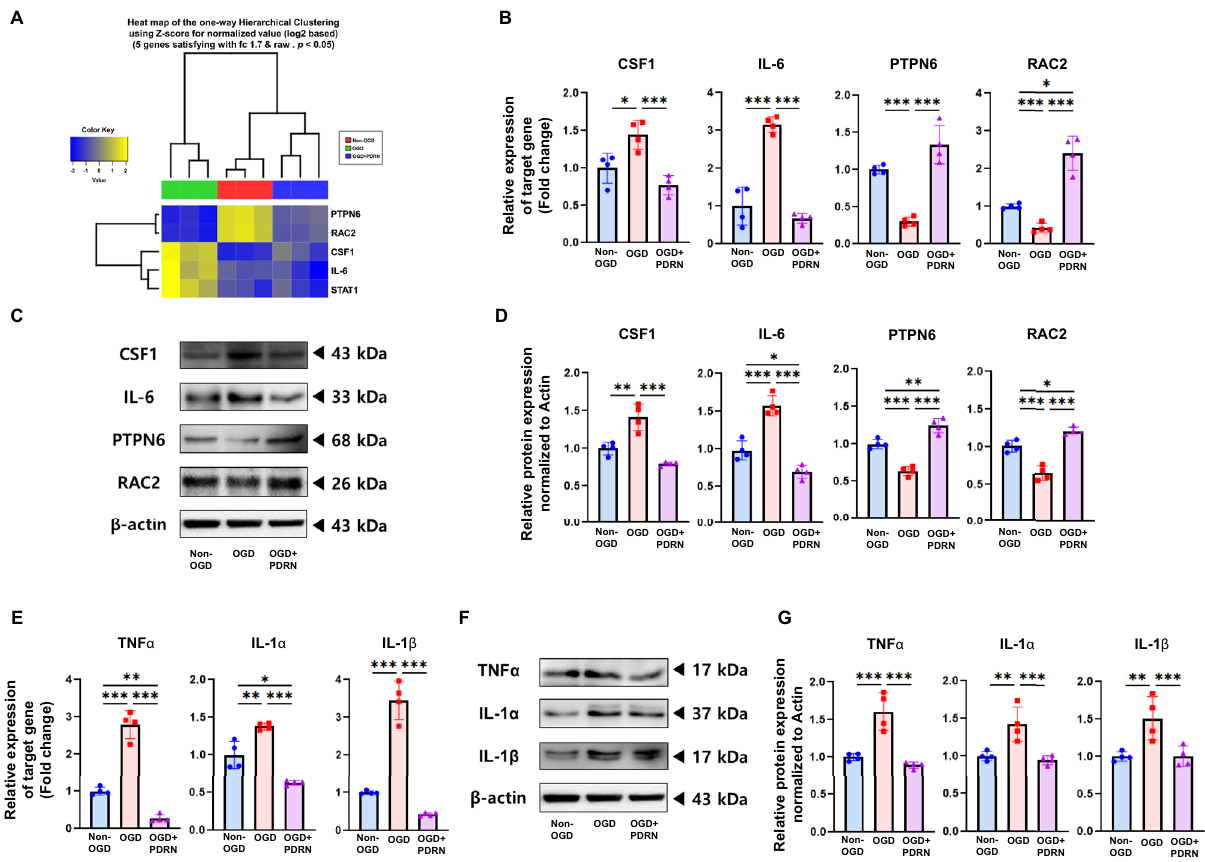
Figure 2. Effect of PDRN on genes related to the inflammation of in vitro I/R injury model. ( A ) Heat map representing effect of PDRN treatment on 5 genes related to the inflammatory response of in vitro I/R model. ( B ) The relative gene expression of CSF1, IL-6, PTPN6, and RAC2 in Non-OGD, OGD, and OGD + PDRN groups detected by RT-qPCR. ( C ) Western blotting analysis of CSF1, IL-6, PTPN6, and RAC2 in Non-OGD, OGD, and OGD + PDRN groups ( D ) Quantification of western blotting signals for CSF1, IL-6, PTPN6, and RAC2. ( E ) The relative gene expression of TNFα, IL-1α, and IL-1β in Non-OGD, OGD, and OGD + PDRN groups detected by RT-qPCR. ( F ) Western blotting analysis of TNFα, IL-1α, and IL-1β in Non-OGD, OGD, and OGD + PDRN groups ( G ) Quantification of western blotting signals for TNFα, IL-1α, and IL-1β. Values are presented as means ± SEM. Statistically significant differences are shown as * p < 0.05, ** p < 0.01, *** p <